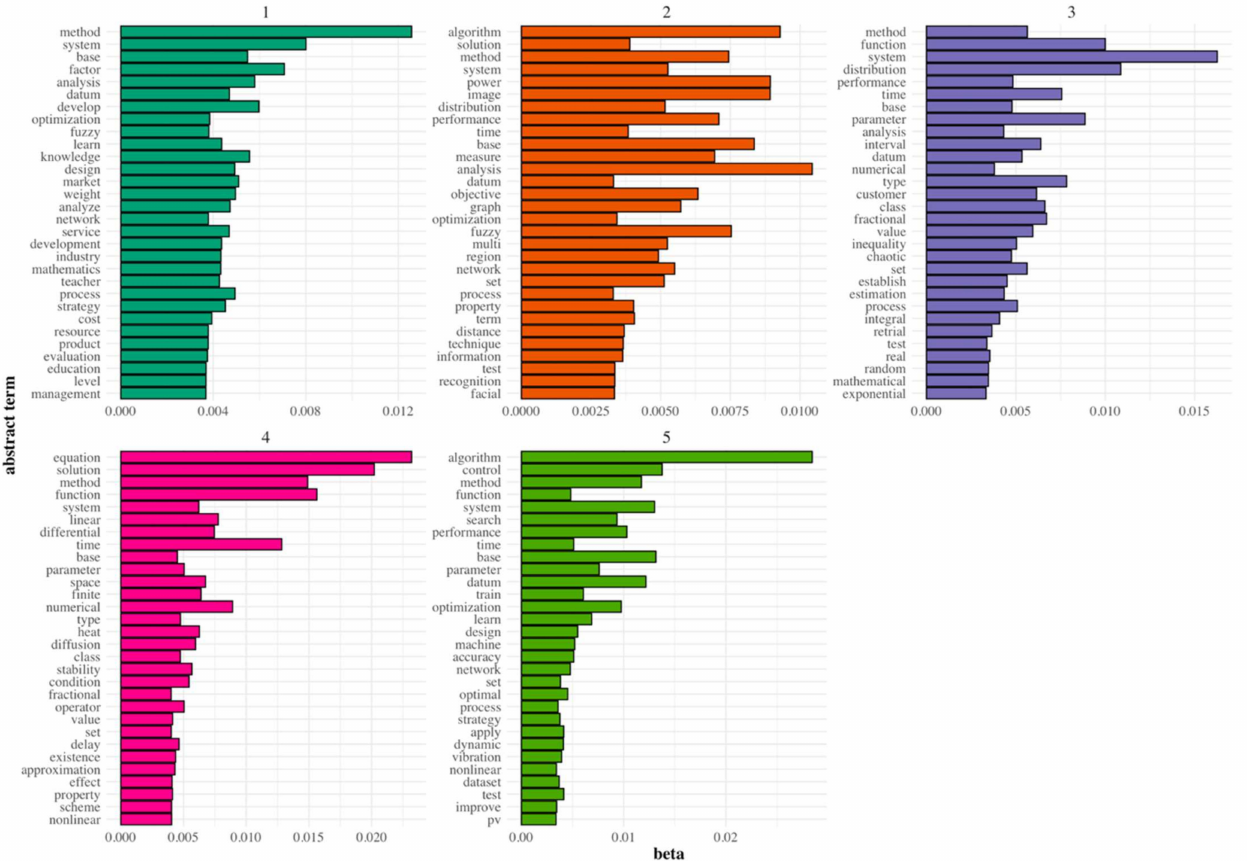
Figure 5. LDA topic modeling analysis using article abstracts. Topics extracted are represented by numbers 1–5 as indicated at the top of each plot facet and by distinct